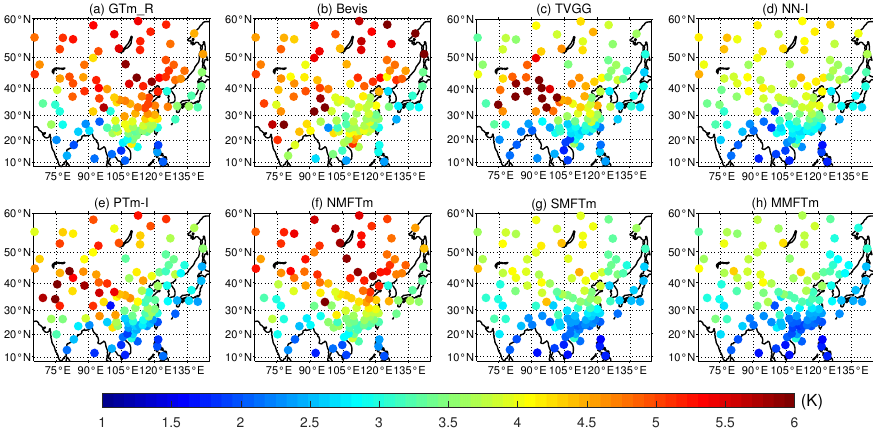
Figure 12. Distribution of S_RMSE for different models tested by radiosonde data from 2016 to 2018 ( a – h ).